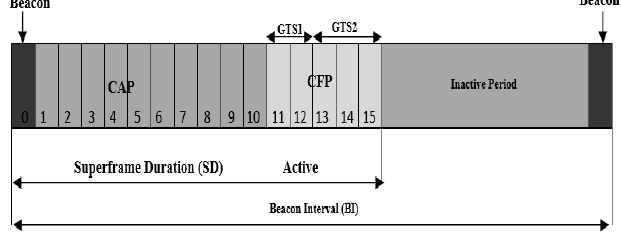
Fig. 1 . Standard IEEE 802.15.4 superframe